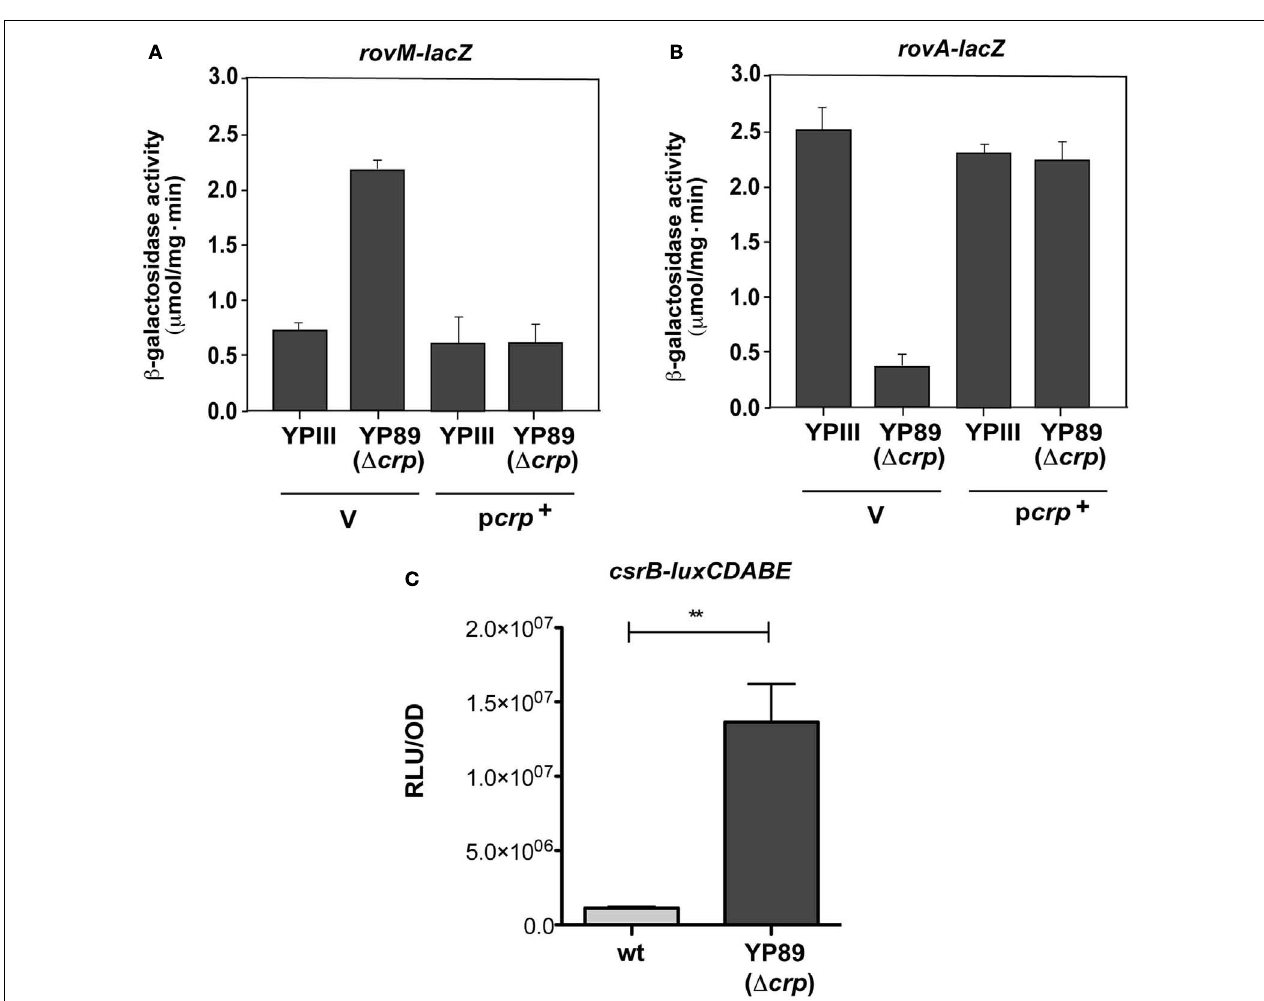
data represent the average ± SD from at least three different experiments each done in duplicate. (C) Y. pseudotuberculosis strainsYPIII andYP89 ( ∆ crp ) harboring a csrB-luxCDABE reporter fusion (pWO25) were diluted 1:50 in fresh LB medium from overnight cultures and grown for 12h to early stationary phase at 25˚C. Bioluminescence was determined as described in Section “Materials and Methods” and is given as relative light units (RLU) per optical density at 600nm